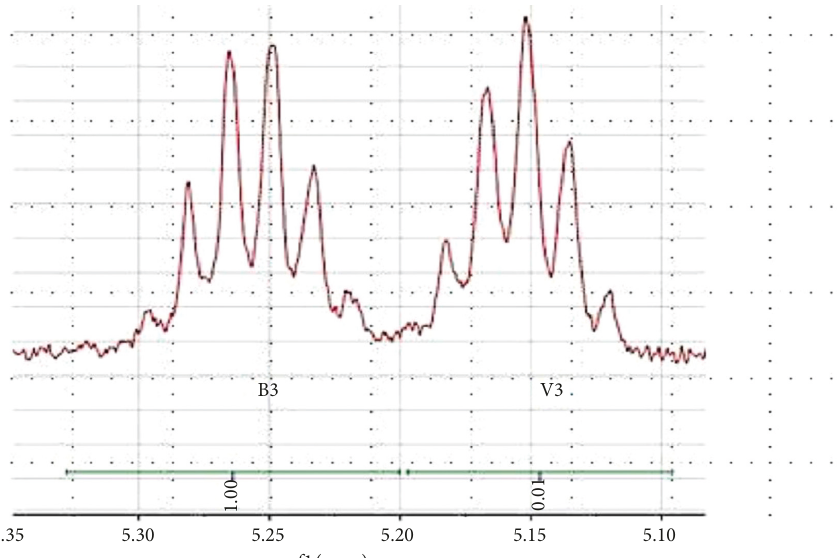
Figure 2: The monomer compositions analysis of purified PHA-extracted material from R. rubrum (ATCC 11170) by 1 H-NMR.